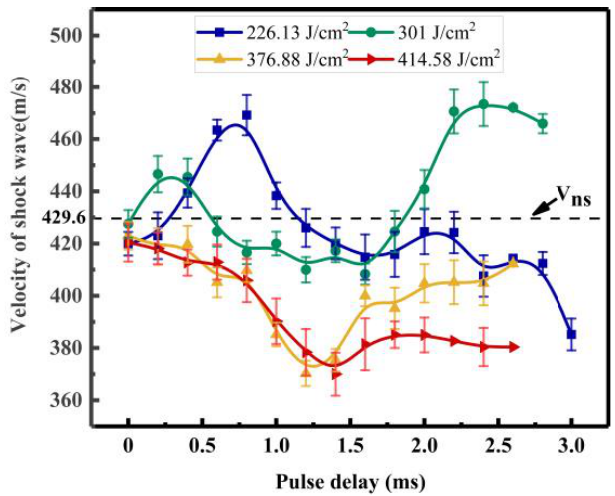
Figure 3. The relation between shock wave velocity and pulse delays.